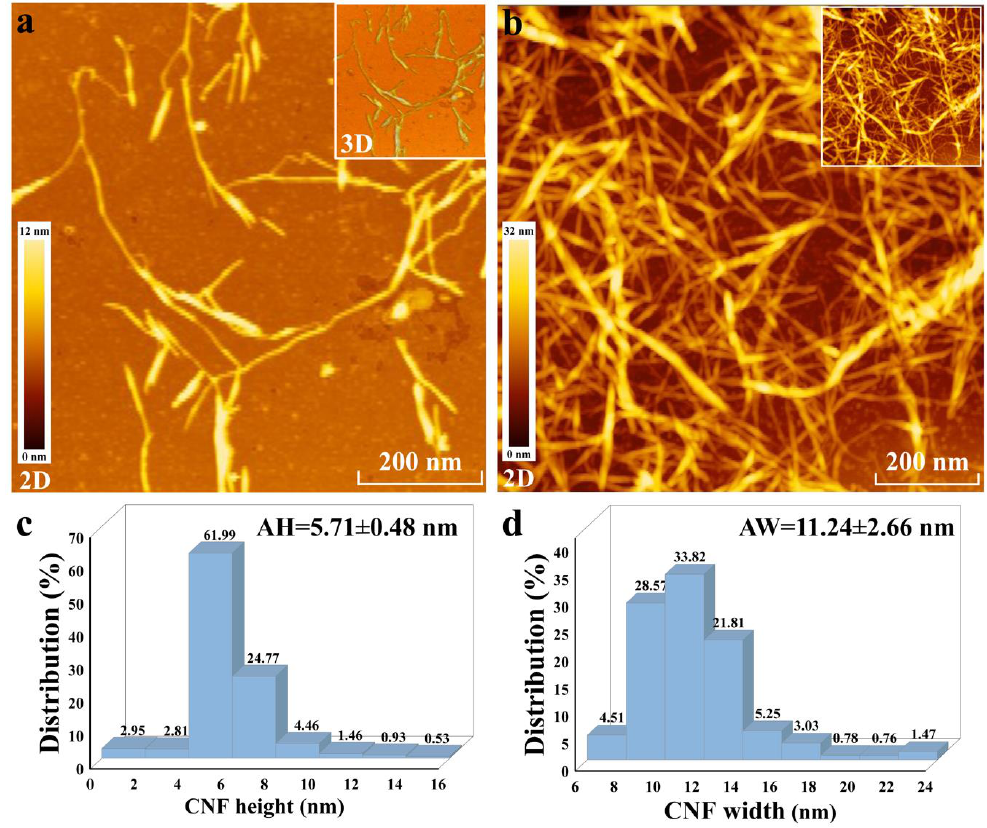
Figure 4. ( a ) Atomic Force Microscopy (AFM) image of CNF samples prepared based on the method by poly(ethyleneimine) solution (PEI) substrate adsorption; ( b ) AFM image of CNF samples prepared based on the method by dropping the suspension; and ( c ) height distribution and ( d ) width distribution of the CNFs measured based on AFM images (AH: average height and AW: average width).